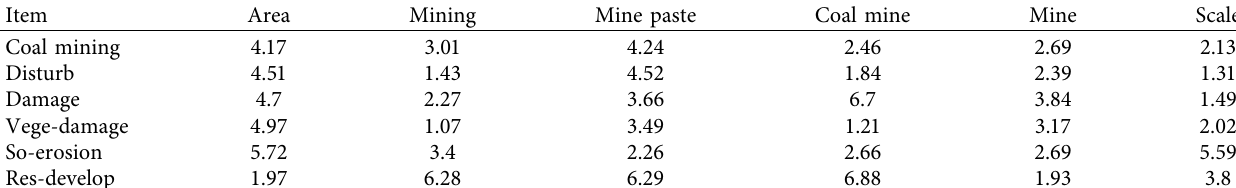
Table 4: The evolution data of the overall stiffness of the staggered assembly structure. Item